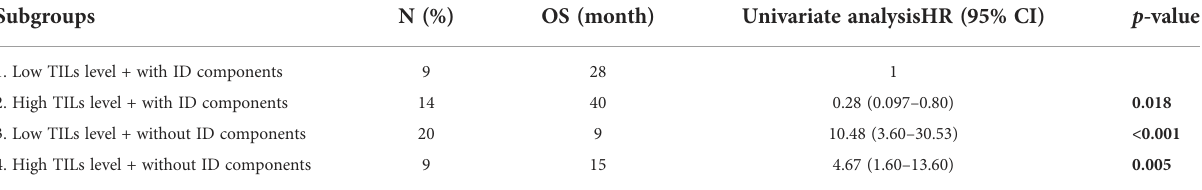
TABLE 3 Subgroup analysis of the TIL levels and growth patterns in the outcome patients with distal cholangiocarcinoma.